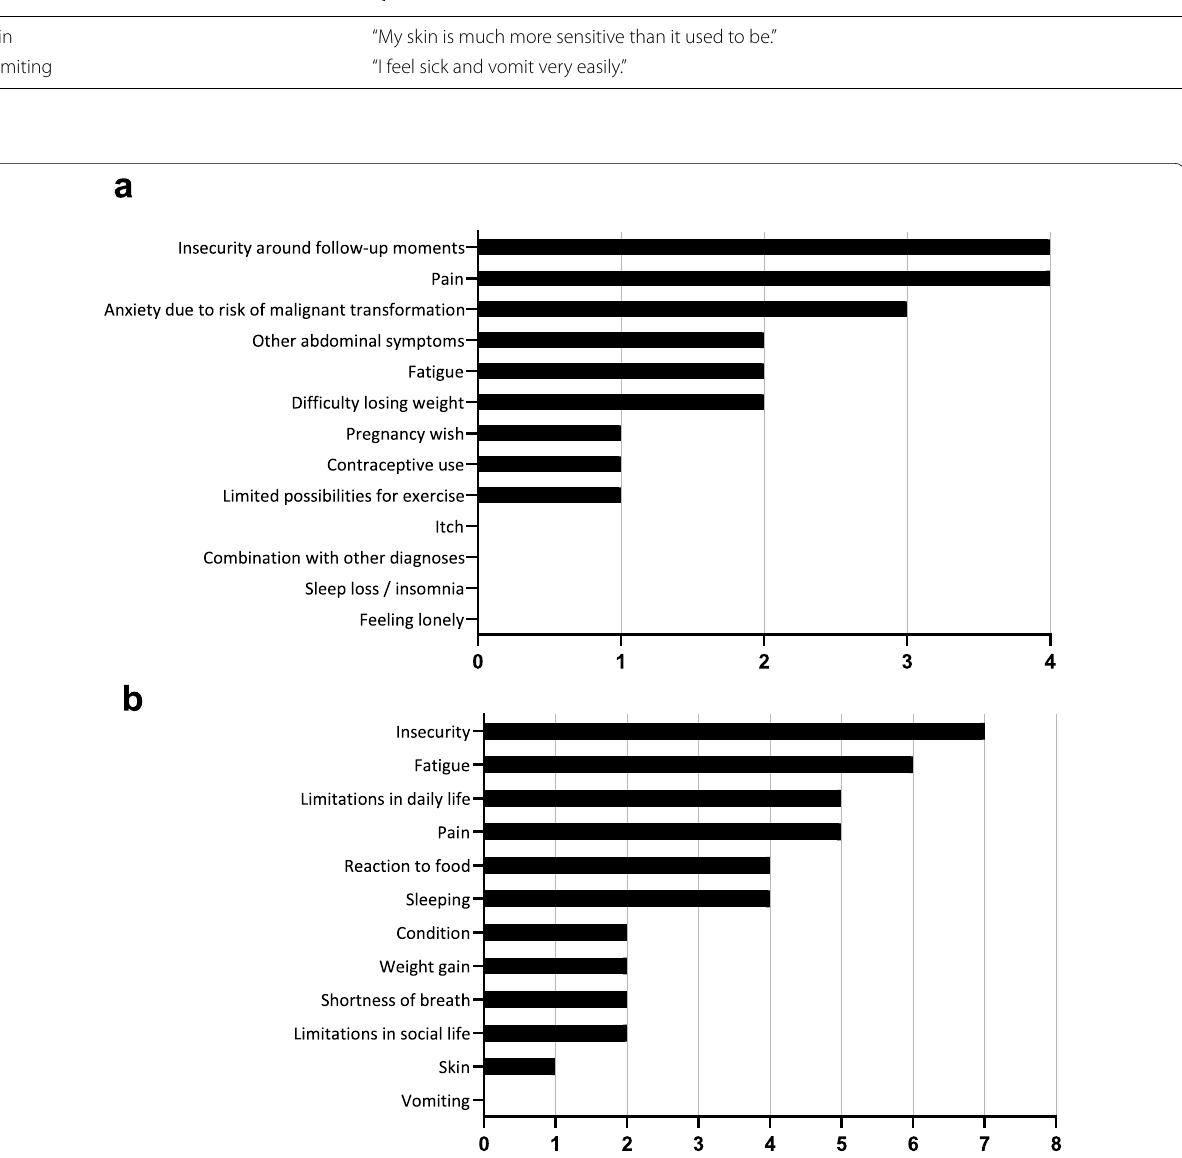
Fig. 1 Quantitative assessment of PROs for patients with BLTC identified in the focus groups. Figures show the number of patients noting the PRO in their top-five of most important PROs. a In focus group 1, including patients with HCA ( n 4). b In focus group 2, including patients with FNH, = hepatic hemangioma and simple hepatic cysts ( n =